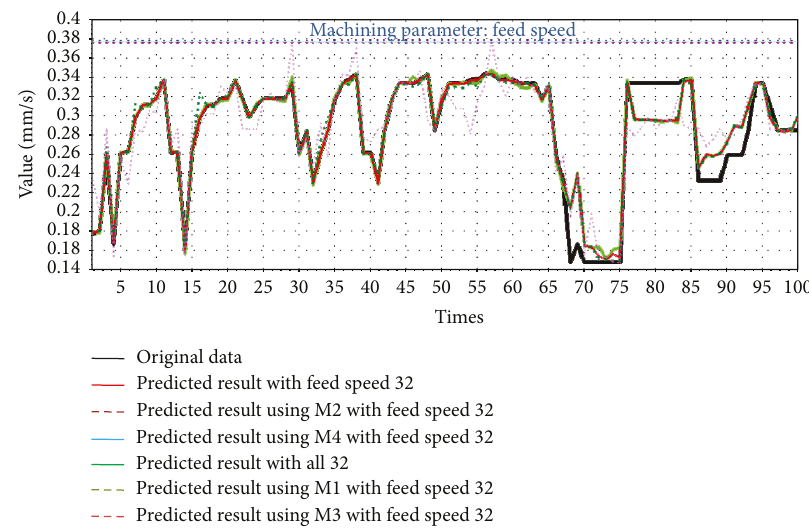
Figure 20: Predicted results of feed speed of grinding wheel.